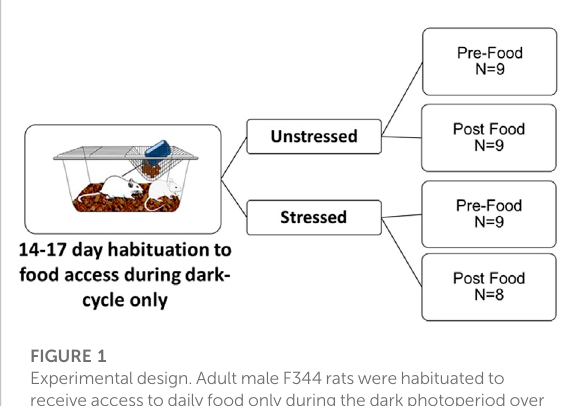
FIGURE 1 Experimentaldesign.AdultmaleF344ratswerehabituatedto receive access to daily food only during the dark photoperiod over 14 – 17 days. Rats were then either left undisturbed in home cages (Unstressed) or exposed to an episode of unpredictable tail shocks(Stressed).Forty-eighthoursafterstress,ratsweresampled either 15 min prior to food access (Pre-Food) or 30 min after food access (Post Food) to measure monoamine related neurochemicals across the intestines, intestinal contents, and liver using